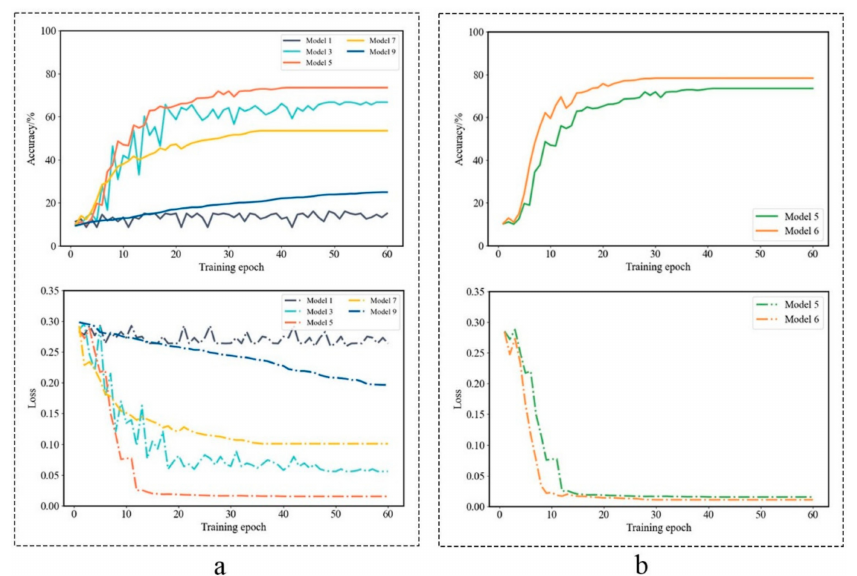
Figure 7. Change in accuracy/loss for the grassland-type recognition model: ( a ) Under different initial learning rates—the initial learning rates used in model 1, model 3, model 5, model 7, and model 9 are 0.1, 0.05, 0.01, 0.005, and 0.001, respectively. ( b ) With and without data augmentation—model 5 is without augmented data; model 6 reflects data